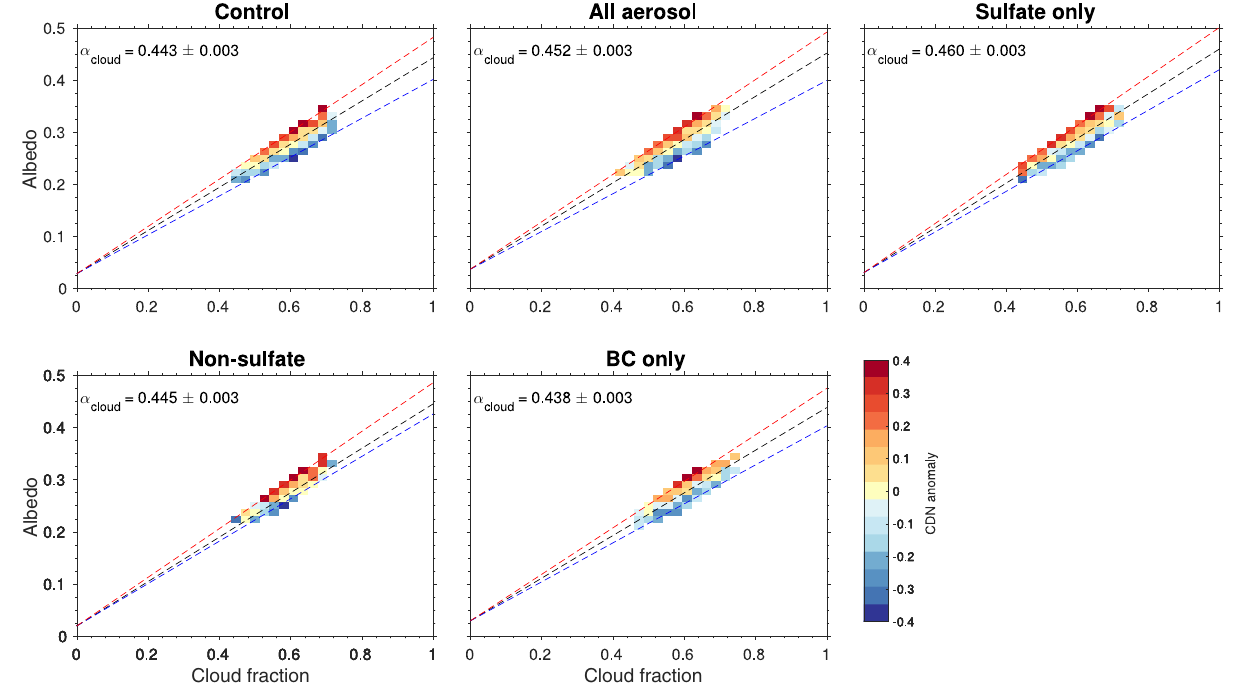
Figure 3. CDN anomaly gradient for the model NorESM for all experiments in the Californian region. Two linear regressions are performed for the separated upper (red dashed line) and lower (blue dashed line) 10% of the data. The black dashed line represents a linear fit for all the CDN anomaly data, and the estimated cloud albedo is derived from the slope and intercept of that linear regression. The colour scale for the anomaly was normalized by the standard deviation of CDN for each cloud fraction